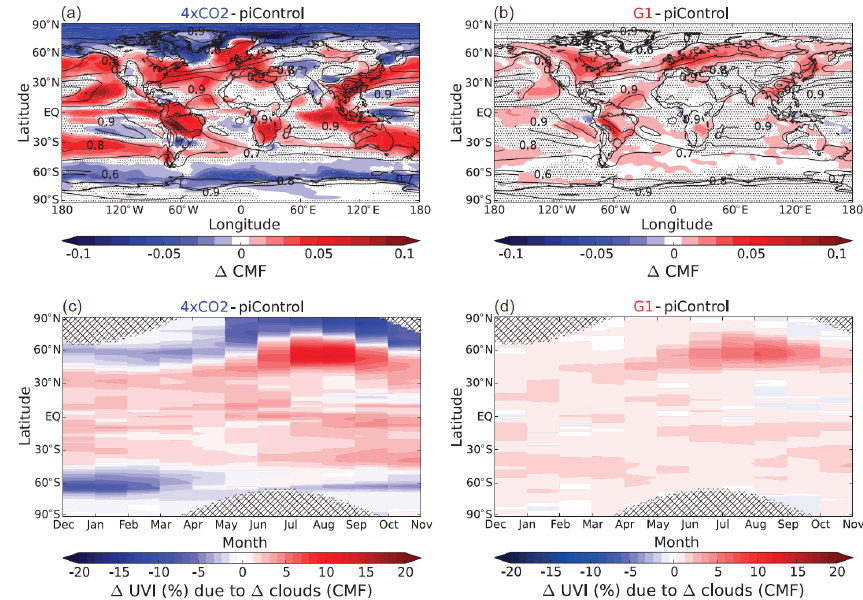
Figure 5. Differences in the cloud modification factor and their impact on the UV index. (a) Annual mean (cid:49) CMF (colours) under 4 × CO 2 and (b) under G1 relative to piControl (contour lines). Non-significant changes (using a two-tailed Student’s t test at the 95% confidence level) are marked by stippling. Zonal mean percentage changes in the UV index at noon induced by (cid:49) CMF are shown for (c) 4 × CO 2 and (d) G1 according to the formulas by den Outer et al. (2005) and Staiger et al. (2008). Polar night regions in (c, d) are crossed out; both daily (solar declination) and monthly changes (ozone) are considered, giving rise to a less smooth